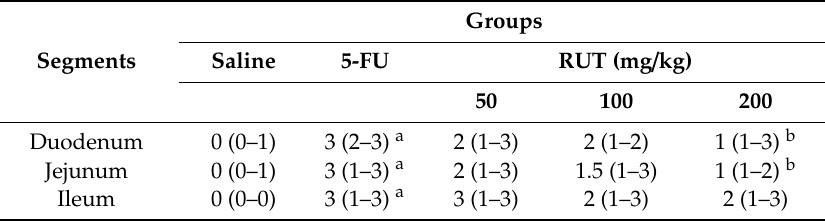
Table 2. Histopathological scores of mice subjected to 5-FU-induced intestinal mucositis and pretreated with RUT.